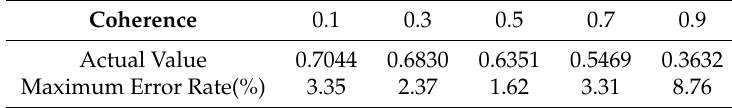
Table 3. Maximum error rate of noise level